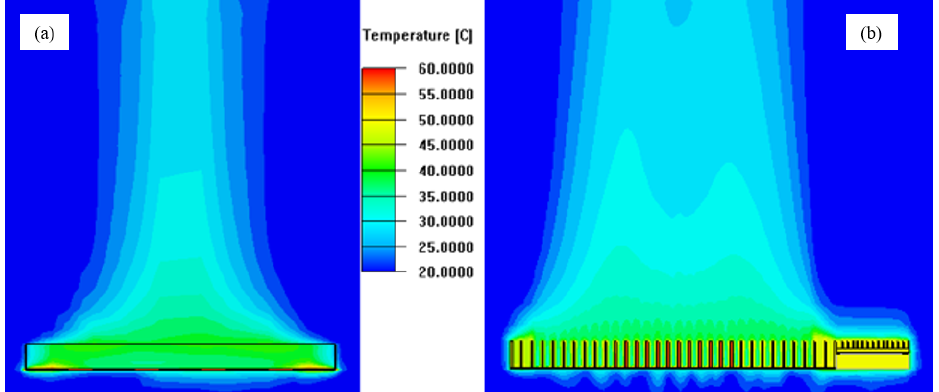
Figure 13. Temperature contours plotted at the array center along the mid-section of the fin channel ( a ) and at the center of opening along the transverse direction ( b ) of the LED grow light ( H = 40 mm, s = 12.85 mm, and Q e = 240